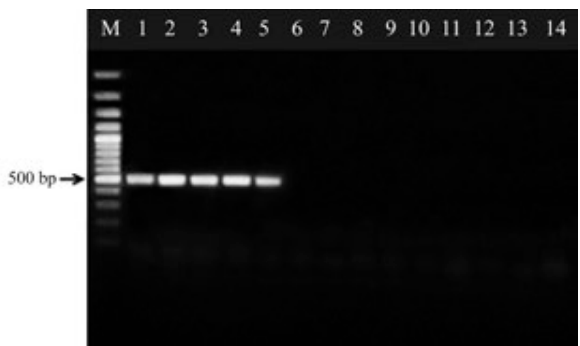
Figure 1. Identification of Togninia minima using a species- specific primer set (PmaleoF/PmaleoR) based on sequenc - es of the β-tubulin gene. Lane M: 100 bp DNA Ladder; Lanes 1–5, different isolates of Togninia minima ; Lanes 6, Pm. iranianum ; 7, T. fraxinopennsylvanica ; 8, T. krajdenii ; 9, T. parasitica ; 10, Phaeomoniella chlamydospora ; 11, Acremonium strictum ; 12, Fusarium proliferatum ; 13, Botryosphaeria doth- idea ; 14, negative control (master